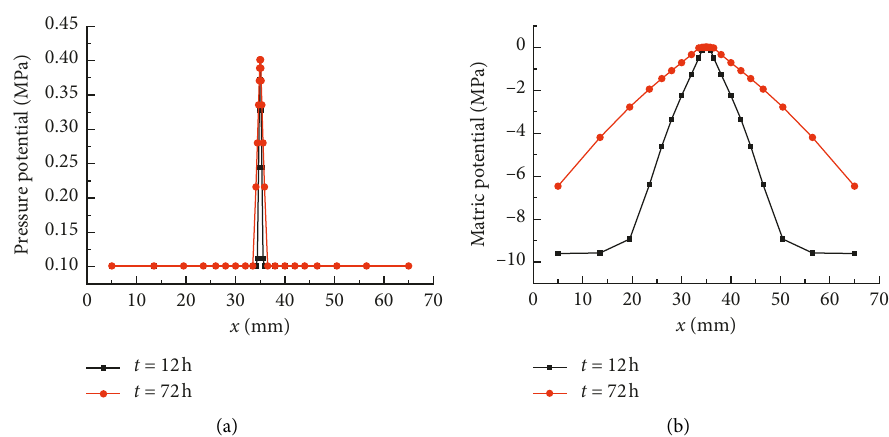
Figure 12: Simulated driving potential of working conditions 1 and 4. (a) Pressure potential. (b) Matric potential.